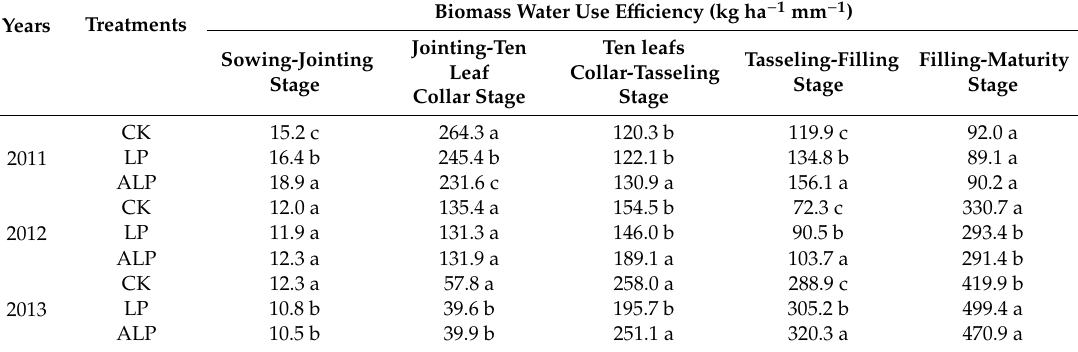
Table 5. E ff ects of di ff erent straw incorporation treatments on biomass water use e ffi ciency at di ff erent growth stages of summer